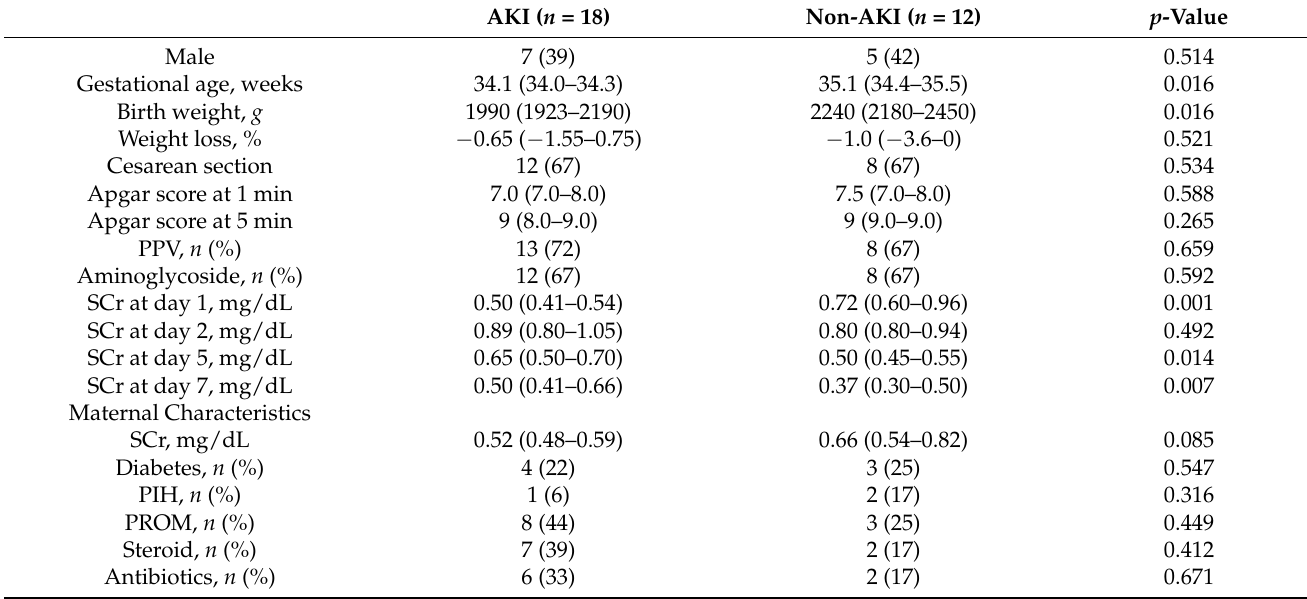
Table 3. Comparison of clinical characteristics between infants with and without AKI.